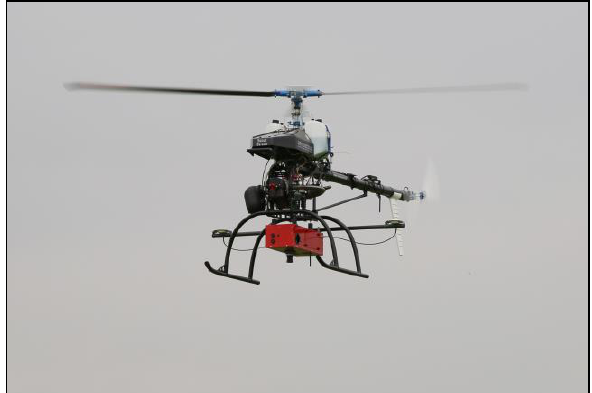
Figure 4: The Scout B1-100 UAV helicopter equipped with the hyperspectral camera during data recording.